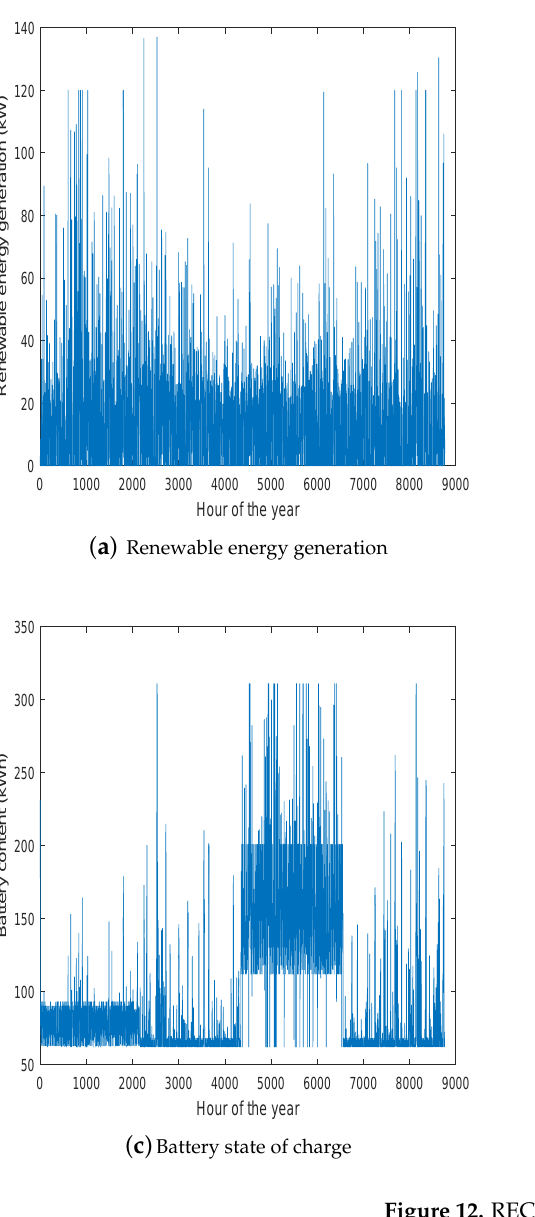
Figure 12. RECCHP in